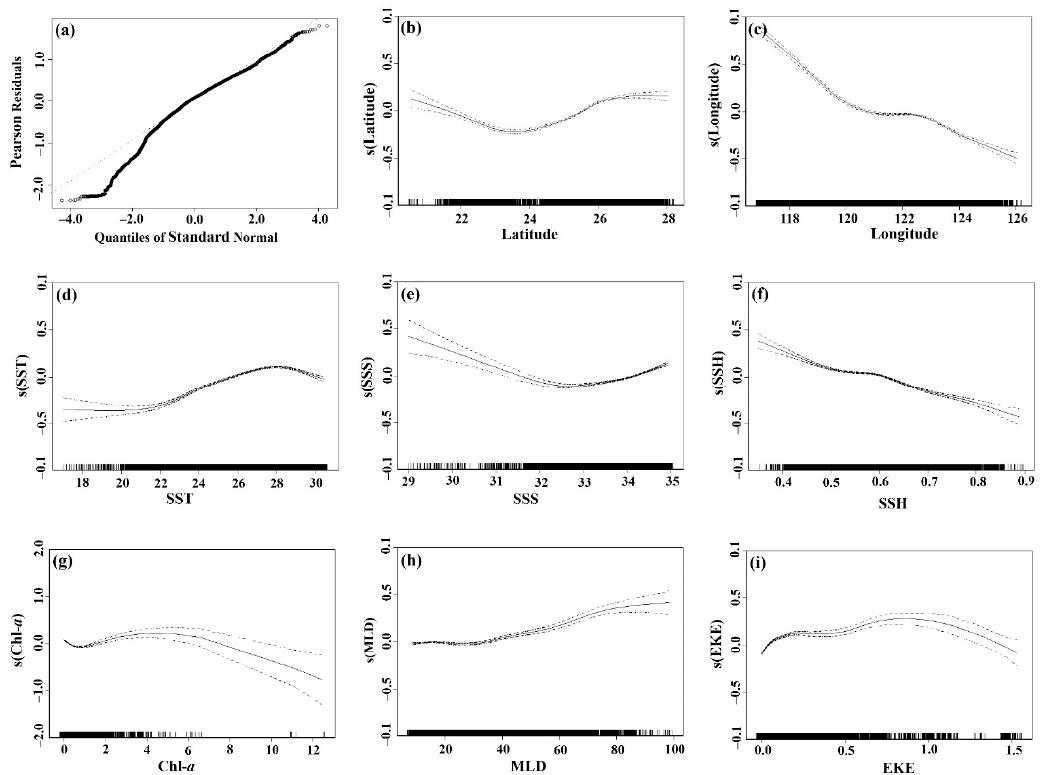
Figure 6. Estimated environmental variable effects derived from the optimal generalized additive model (GAM) analysis of the catch rates of S. dumerili in the TS: ( a ) normal quantile–quantile plots, ( b ) latitude, ( c ) longitude, ( d ) SST, ( e ) SSS, ( f ) SSH, ( g ) Chl- a , ( h ) MLD, and ( i ) EKE. The solid and black dotted lines indicate the fitted GAM function and 95 percent confidence intervals in ( a – i ). On the x -axis, the rug plot depicts the relative density of data points, while the y -axis depicts the results of smoothing the fitted values. Moreover, s ( x n ) denotes each model covariate’s spline smoothing function x n .